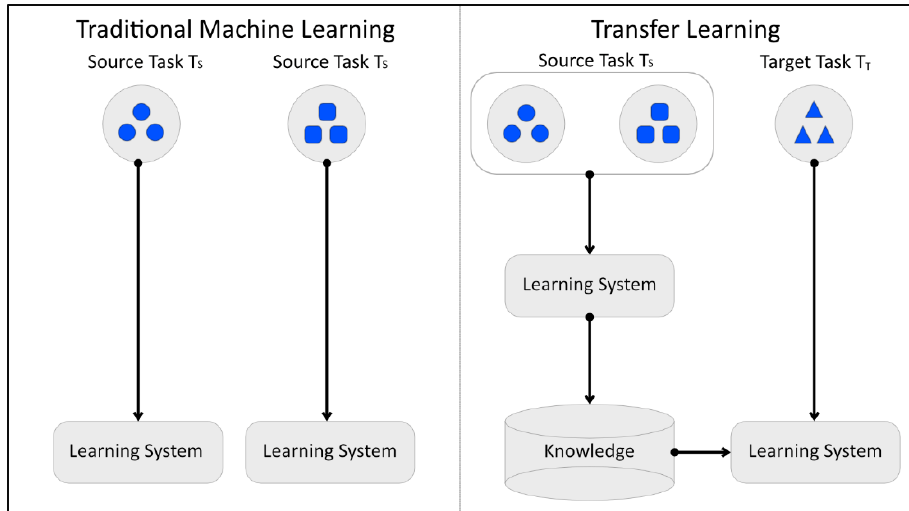
Figure 1. Learning process of traditional vs. transfer learning method.